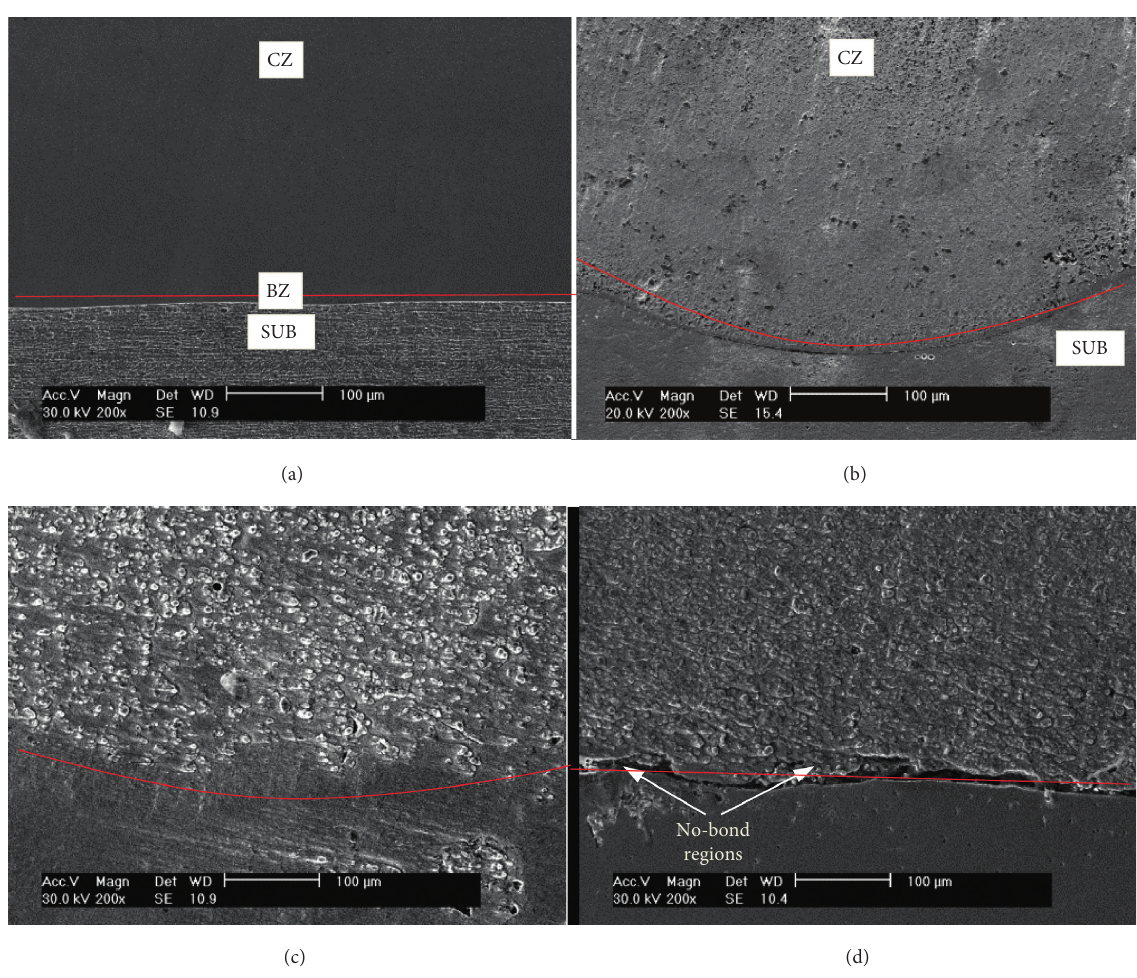
Figure 6: Microstructure of coatings: (a) A coating, (b) B coating, (c) C coating, and (d) D